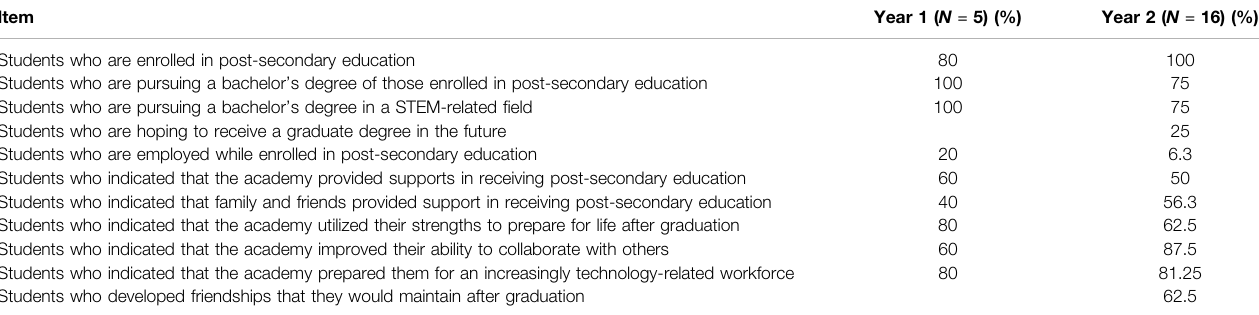
TABLE 6 | Post-graduation survey